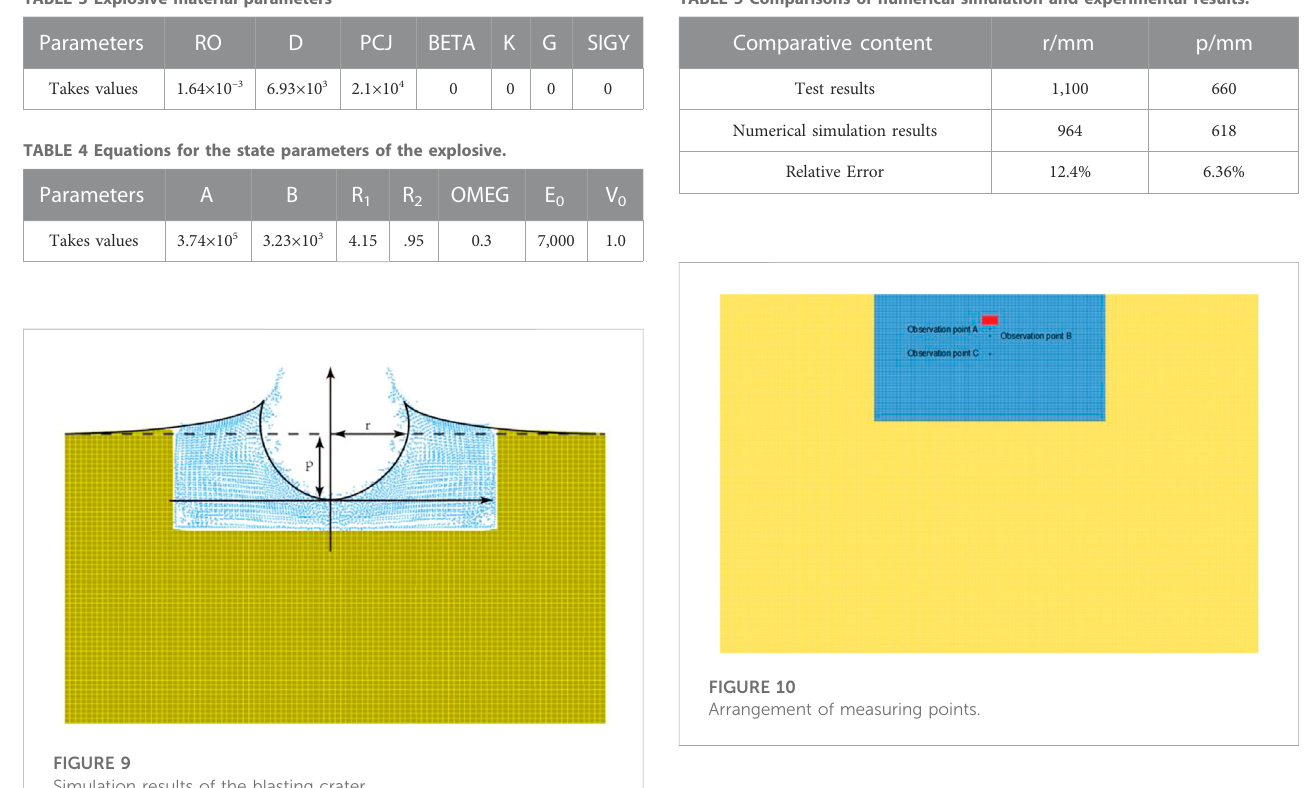
Simulation results of the blasting